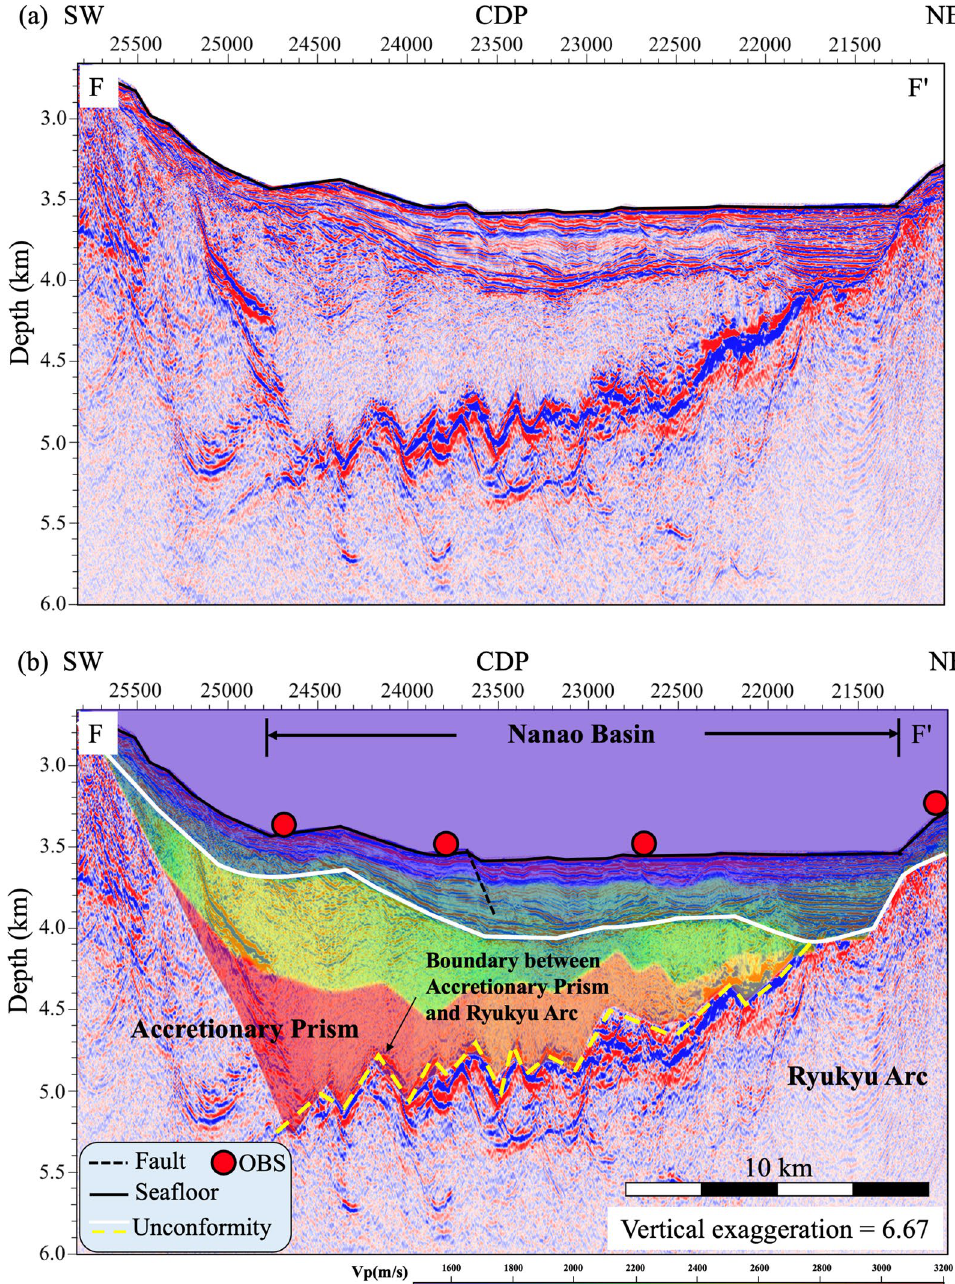
Fig. 6 a The uninterpreted PSDM section and b the horizontal velocity model is superimposed on the PSDM section with interpretations across the Nanao Basement Rise along Line FF’ (Fig. 2) of